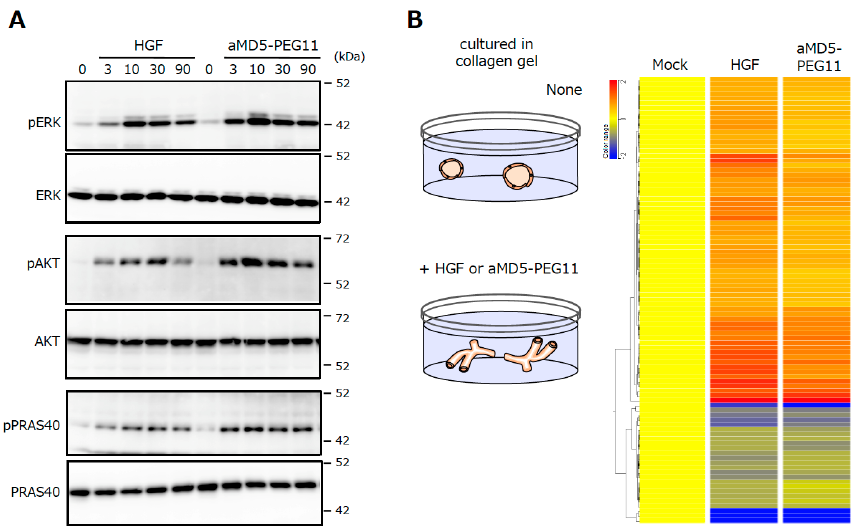
Figure 9. Activation of the intracellular signaling molecules ( A ) and the changes in the gene expression profiles ( B ) induced by HGF and aMD5-PEG11. In A , human mesothelioma cells were cultured in 2D conditions. In B , human renal tubular cells were cultured in 3D collagen gel. These data were taken from our previous report [26].